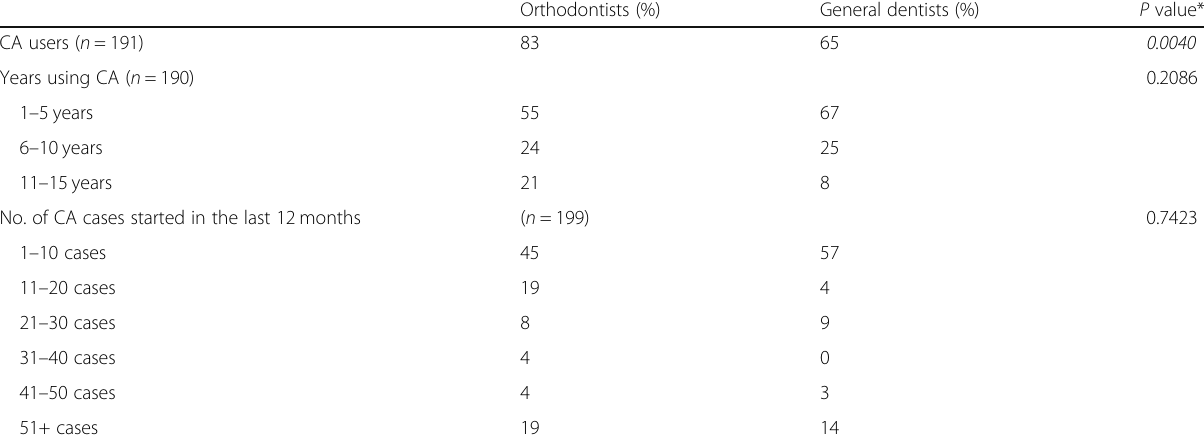
Table 2 Differences between orthodontists and general dentists in experience with CA treatment